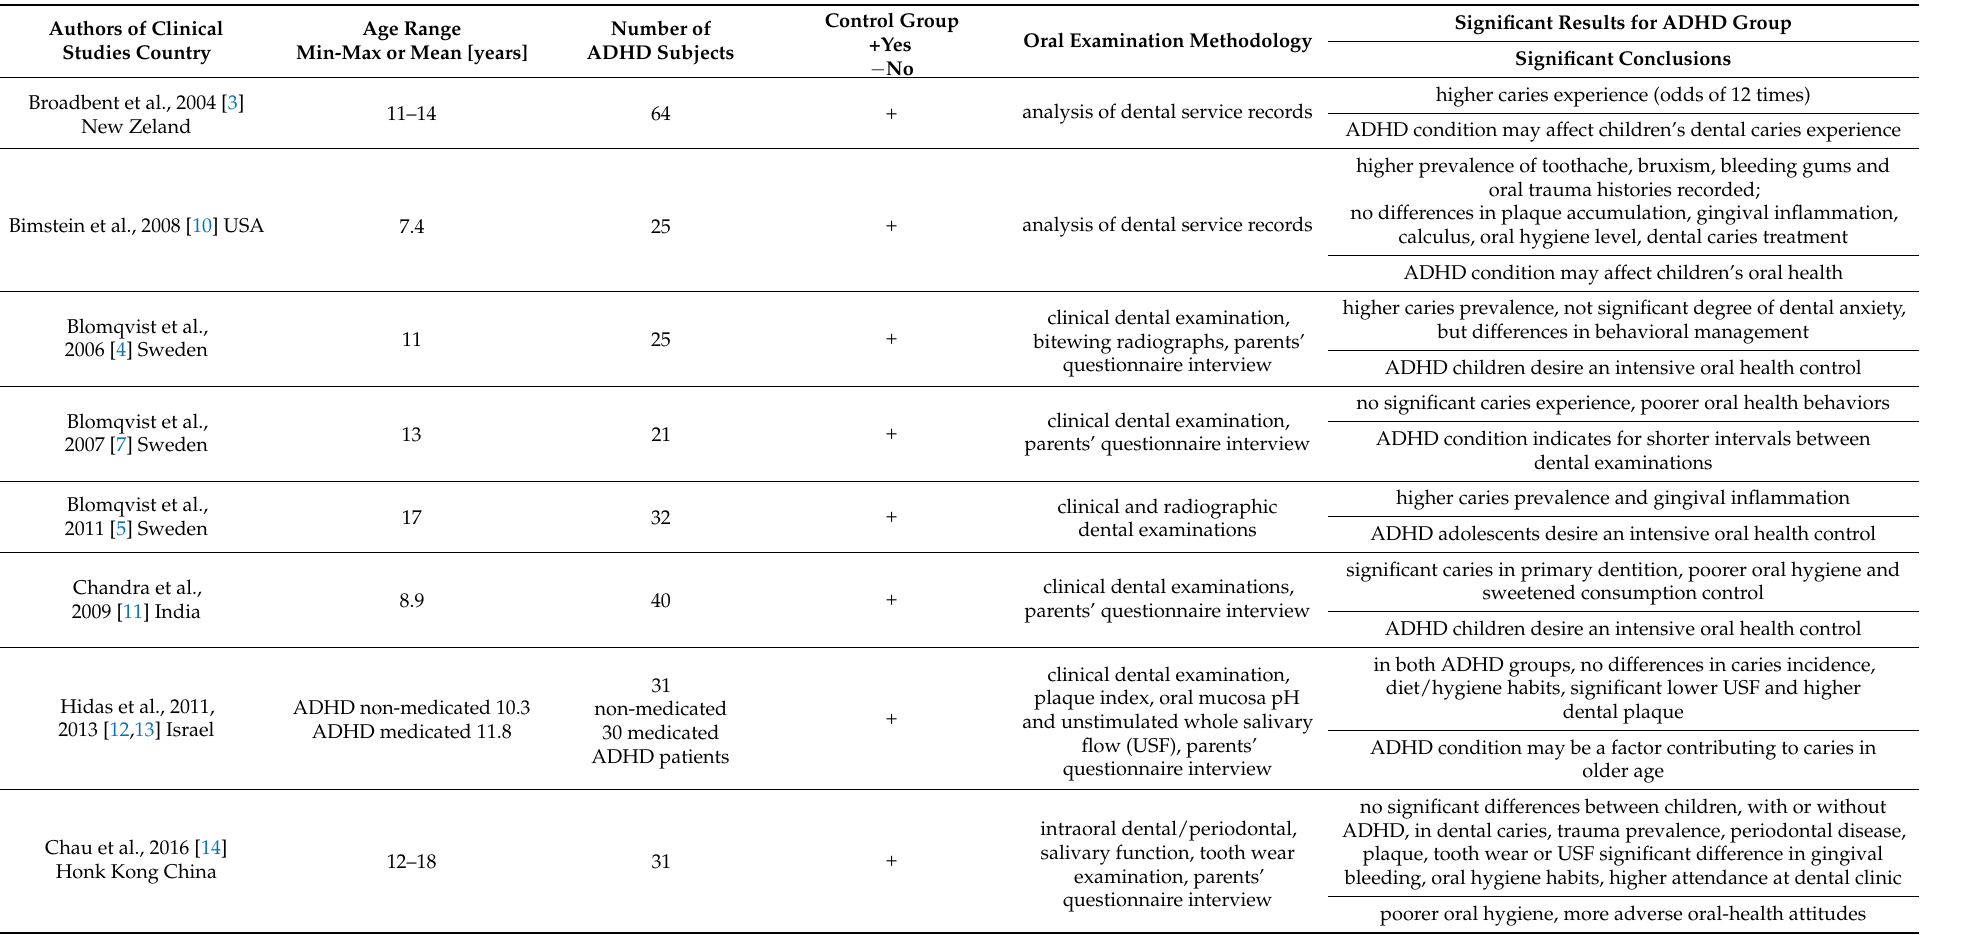
Table 1. A synthesis of data obtained from the electronic research organized in PubMed database and Web of Science. The following MeSH and non-MeSH search terms were used: (“ADHD” [MeSH terms], [All fields] OR “Oral Health” [All fields]). “Caries” and “Children and Adolescents” include the following terms: Attention Deficit Disorder with Hyperactivity, Child, Cross-Sectional Studies, Caries Index, Dental Caries Complications, Prevalence. The search selected publications only with an ADHD group of subjects published in English language